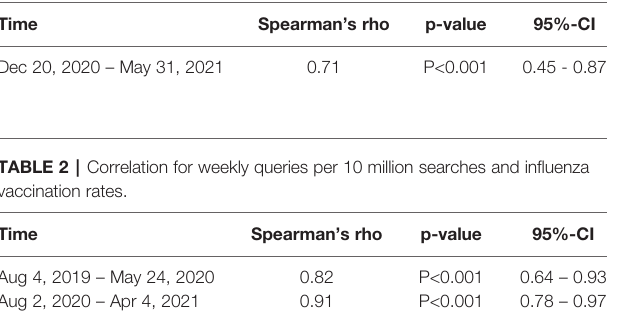
TABLE 1 | Correlation for weekly queries per 10 million searches and COVID-19 vaccination rates.